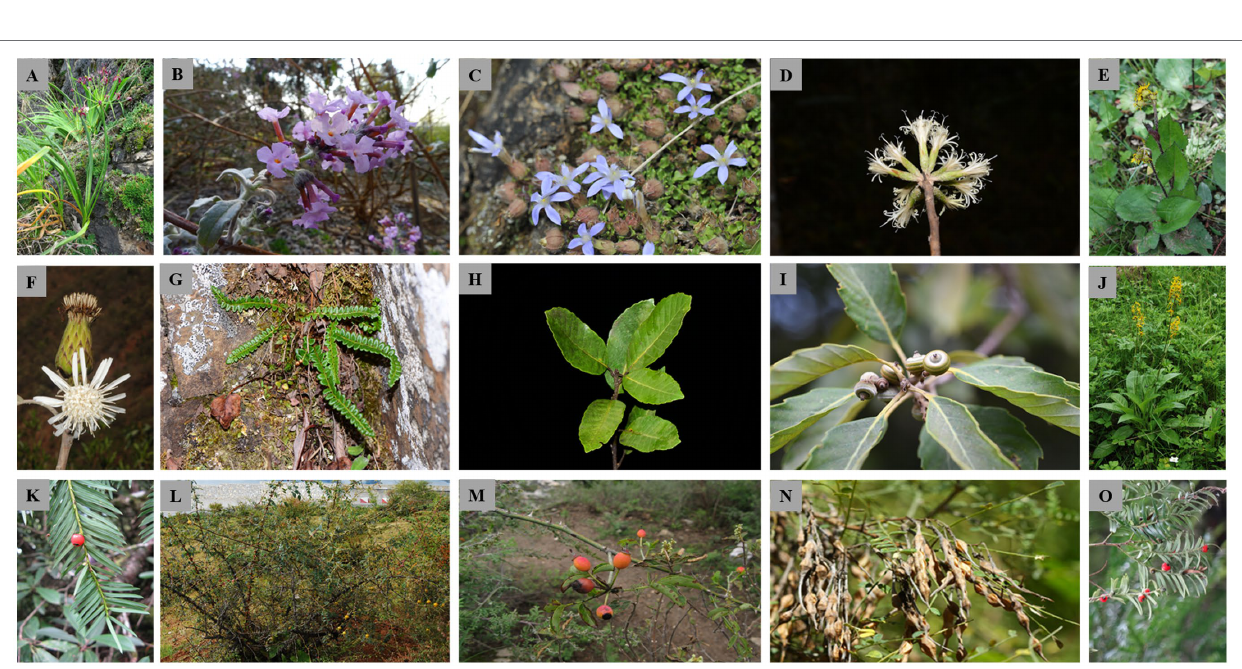
FIGURE 2 | Representative individuals of the 15 plant species analyzed in the present study. (A) Allium wallichii ; (B) Buddleja crispa ; (C) Cyananthus delavayi ; (D) Leucomeris decora ; (E) Ligularia tongolensis ; (F) Nouelia insignis ; (G) Polystichum glaciale ; (H) Quercus kerrii ; (I) Q. schottkyana ; (J) Ligularia vellerea ; (K) Taxus florinii ; (L) Rosa praelucens ; (M) R. soulieana ; (N) Sophora davidii ; and (O) T. wallichiana . Permission to use the photographs was granted by the Germplasm Bank of Wild Species, Kunming Institute of Botany, Chinese Academy of